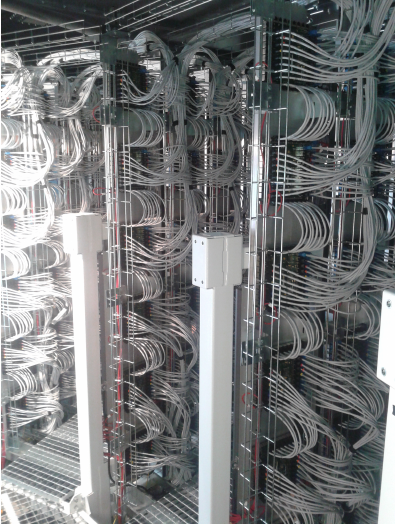
Figure 2. Inside ARUZ. DBoards on interconnected